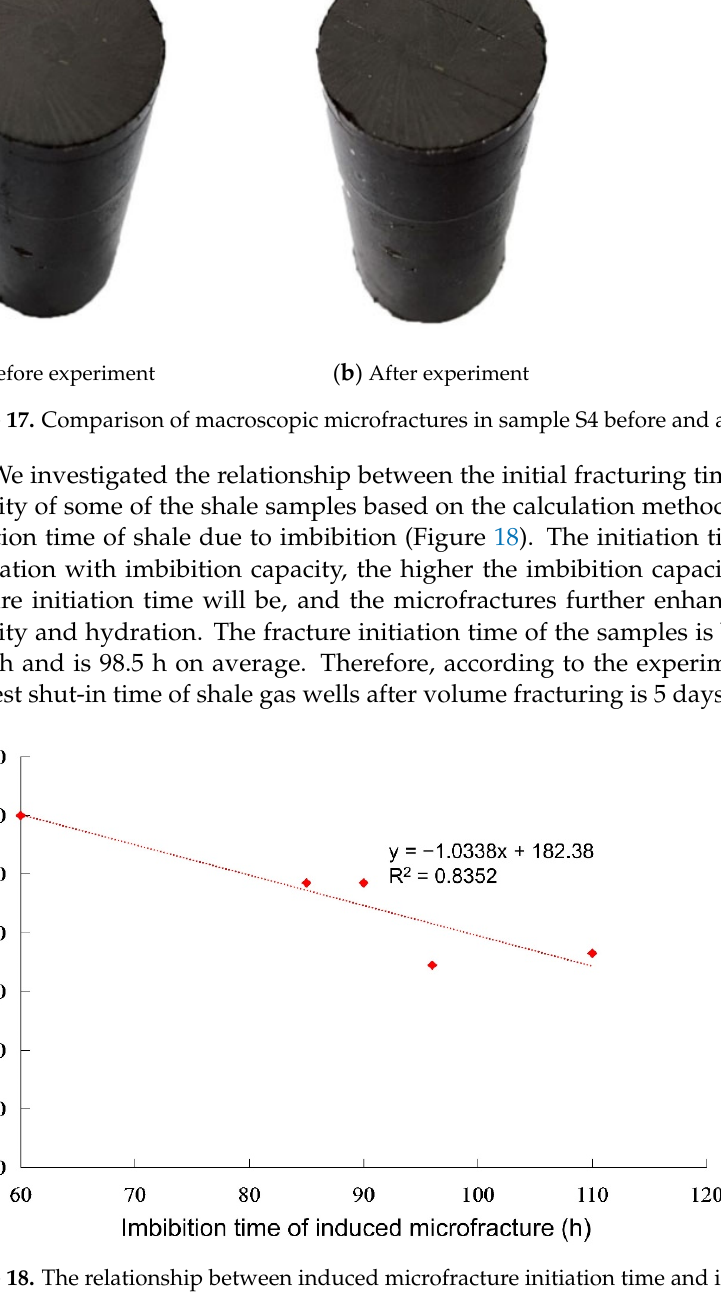
Figure 16. Comparison of porosities and permeabilities of 3 shale samples before and after imbibi ‐ tion.